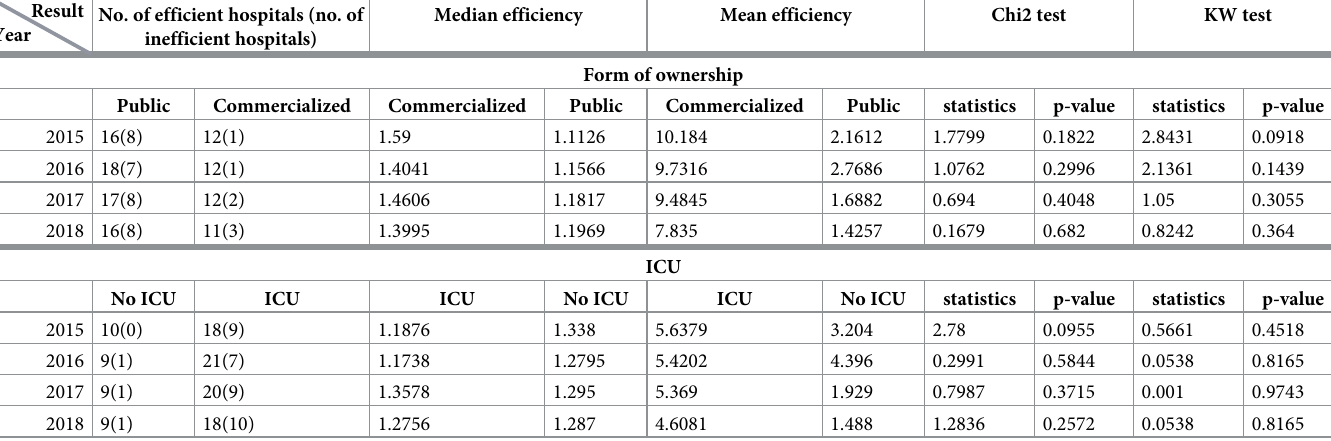
Table 6. Efficiency of hospitals without an ED with respect to the form of ownership and ICU ( detailed approach). Result